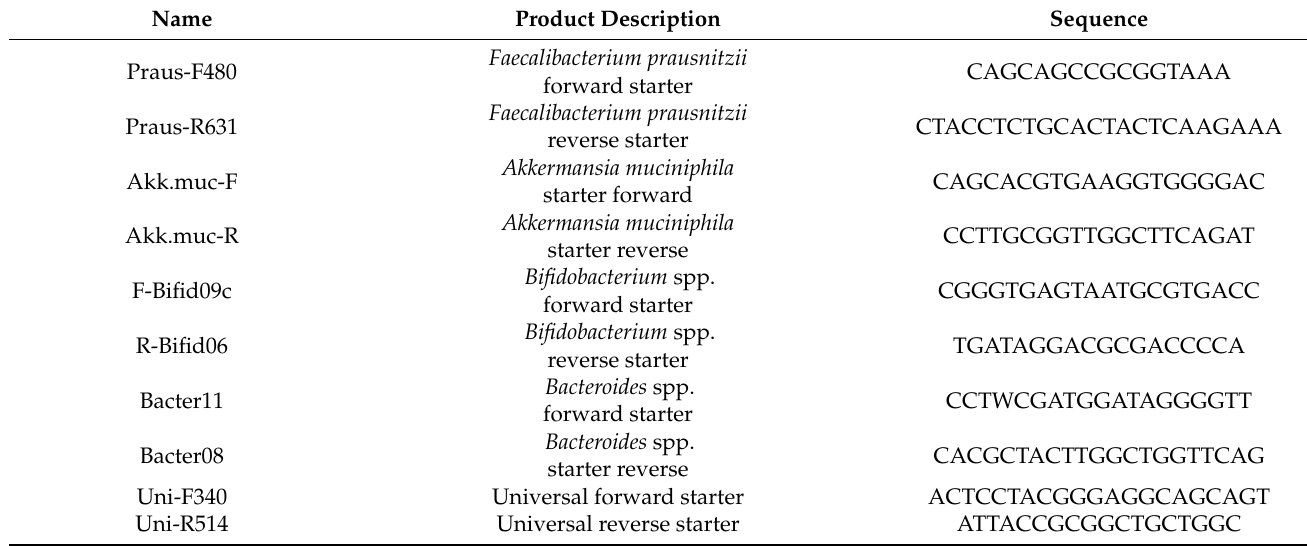
Table 1. Primers used for the determination of different